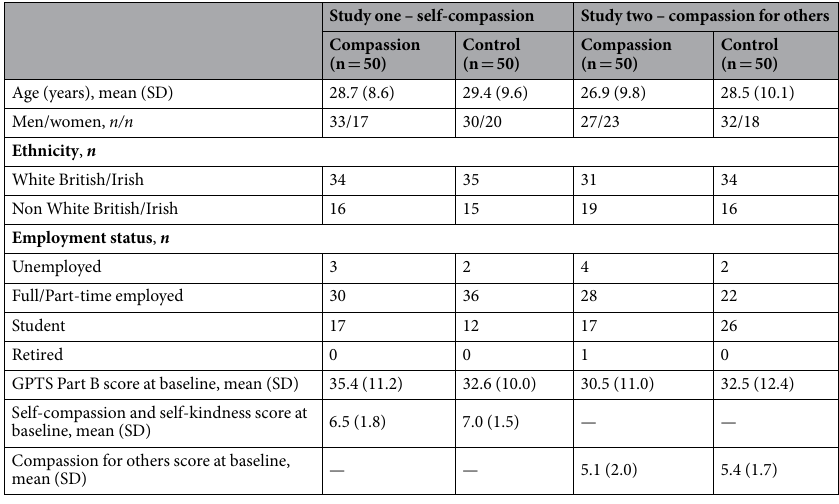
Table 1. Baseline and demographic characteristics by randomisation group.